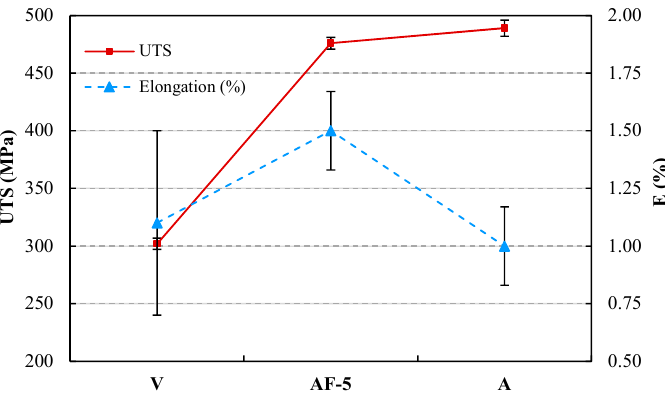
Figure 4. Ultimate tensile strength (UTS) and elongation (E) of sintered compacts.